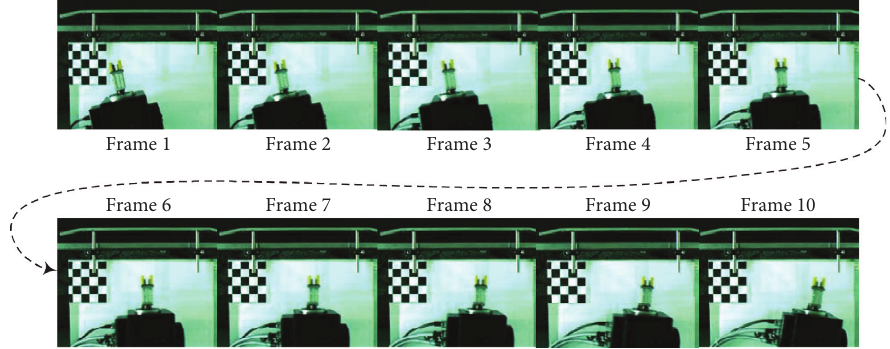
Figure 10: The image sequences of 10